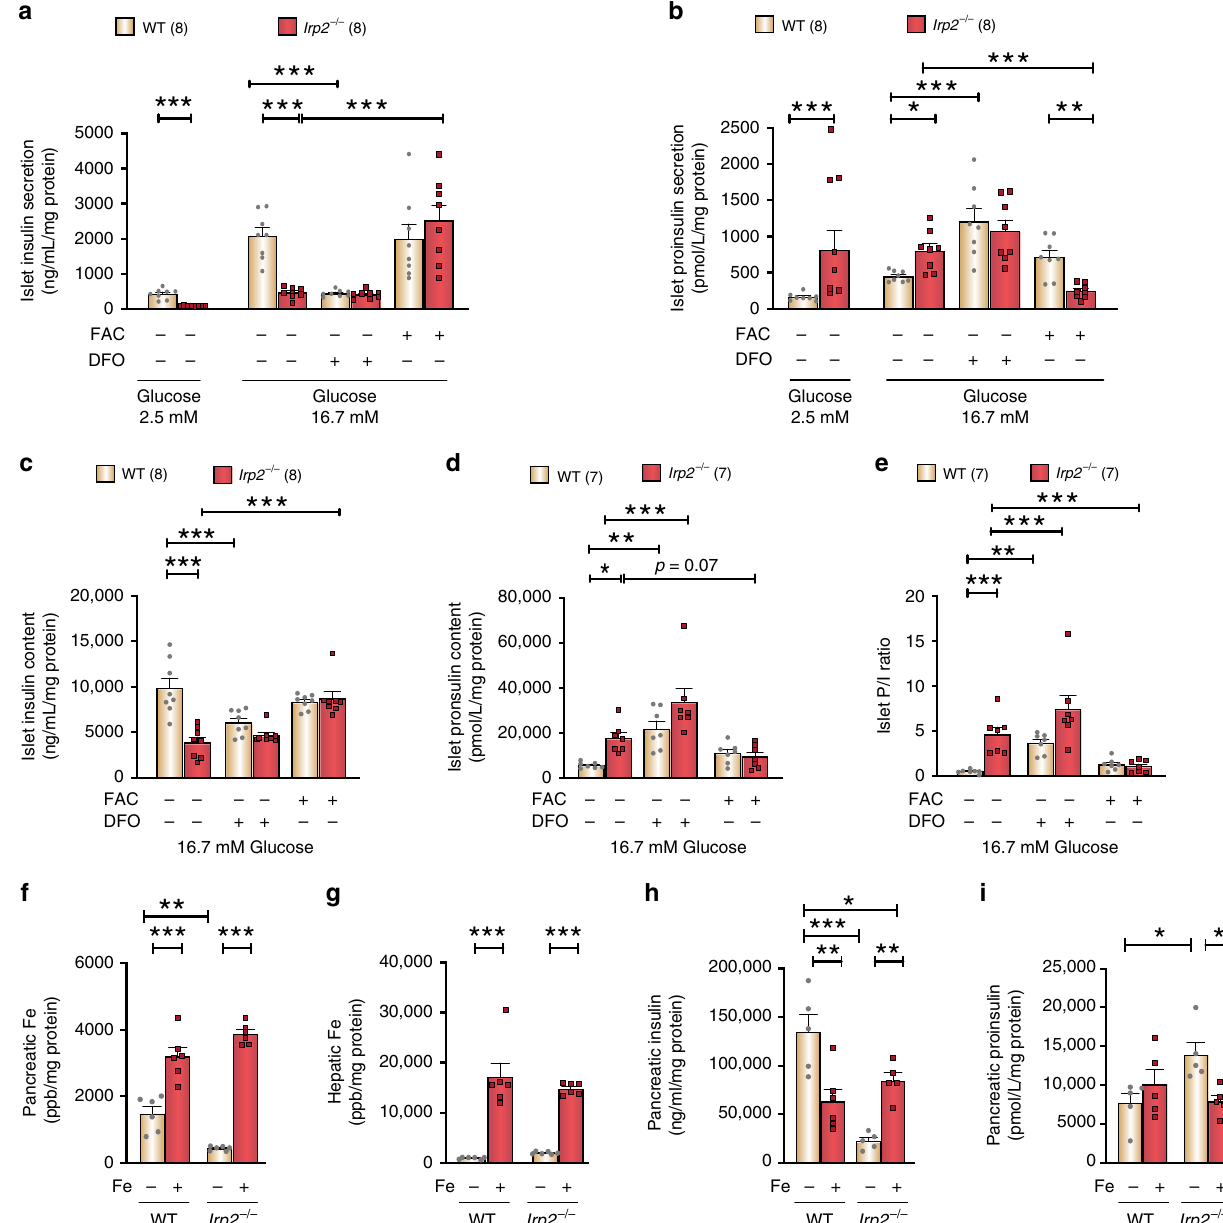
Fig. 5 Iron normalizes insulin and proinsulin secretion and content in Irp2 − / − islets and mice. a – e Glucose-stimulated insulin ( a ) and proinsulin secretion ( b ), total insulin ( c ), and proinsulin ( d ) content and islet P/I ratio ( e ) in WT and Irp2 − / − islets from 7.5-month-old mice. Insulin and proinsulin secretion were assessed under basal glucose (2.5 mM) and after culture overnight in the presence of DFO (50 µ M) or FAC (50 µ g/ml) under high glucose (16.7 mM). The number of mice used is indicated in parentheses. f – i WT and Irp2 − / − mice were i.p.-injected with iron dextran or PBS alone for 5 days, and pancreatic ( f ) and hepatic ( g ) iron content was quanti fi ed by ICP-MS and normalized to total cellular protein. Pancreatic insulin ( h ) and proinsulin ( i ) content were normalized to total cellular protein. Data are expressed as means± s.e.m., one-way ANOVA with Tukey ’ s multiple comparisons test for a – i , * p < 0.05, ** p < 0.01, *** p < 0.001. Source data are provided as a Source Data fi